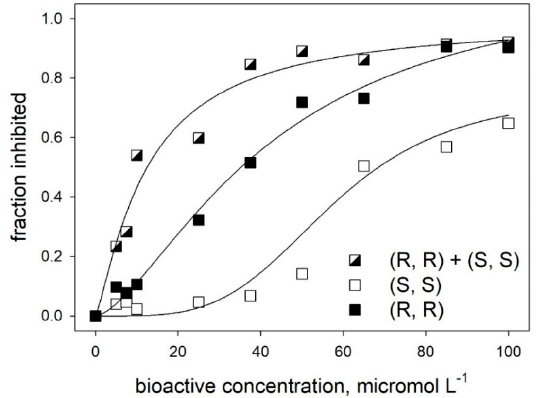
Figure 7. Hill plot for the inhibition of α -amylase by different enantiomeric forms of trans- δ -viniferin ( 5 ). Lines are the best fit to the experimental data, drawn by using a three-parameters Hill equation (y=a*x^n H /([K i ]^n H + x^n H ).